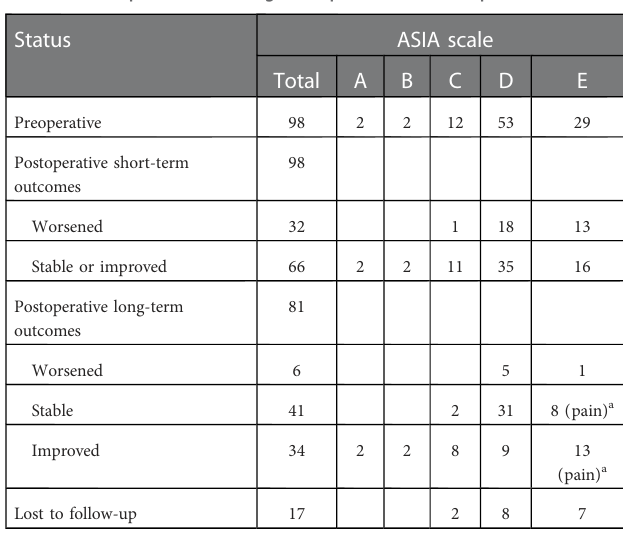
TABLE 4 Postoperative neurological improvement of the patients.